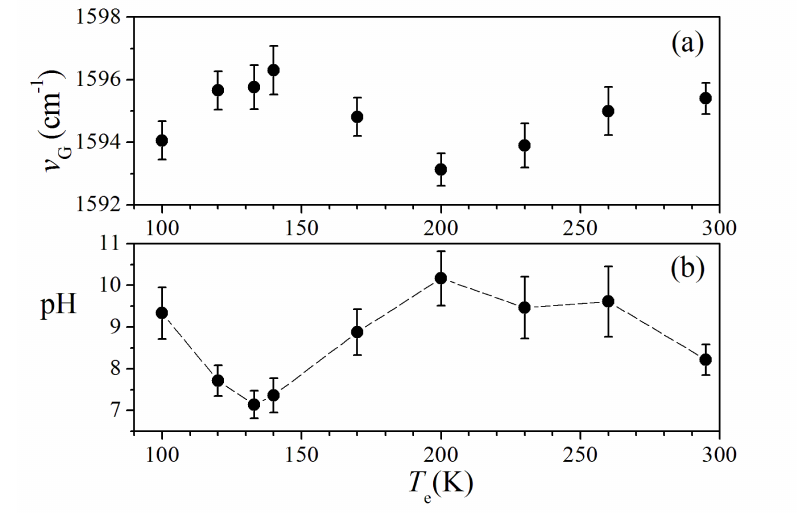
Figure 4. ( a ) Dependence of the graphene ν G energy on the T e temperature. ( b ) Temperature dependence of pH of spore’s environment after low-temperature exposure. The pH values were determined from the value of ν G